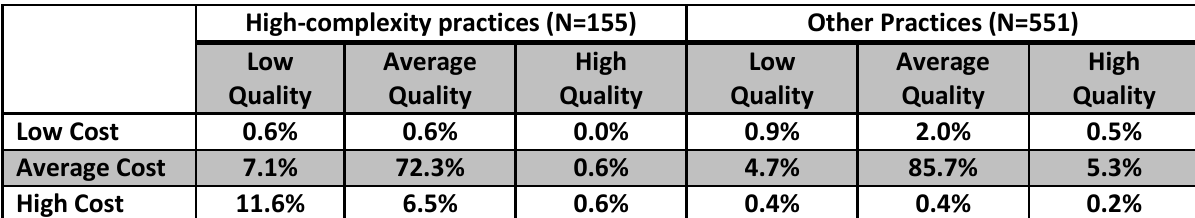
Table 10.13b: Value Modifier by High-complexity Practice vs. Other Practice